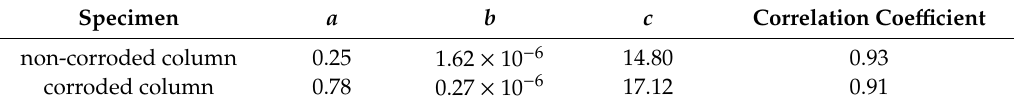
Table 5. Parameters for the correlation curve of the load level and accumulated AE energy.